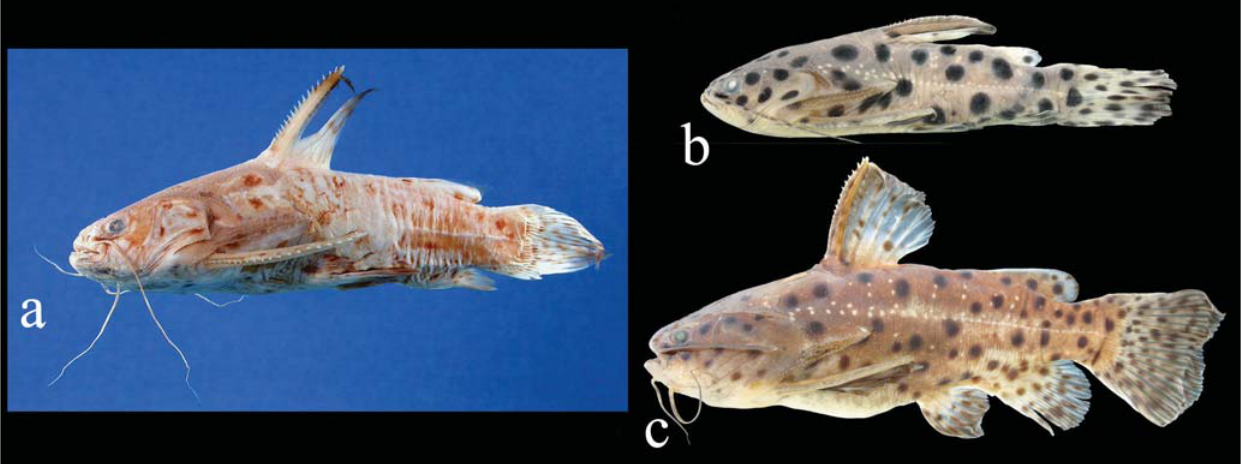
Fig. 11. Liosomadoras morrowi : ( a ) holotype, ANSP 68646, 76 mm SL, río Ucayali basin, Contamana, Peru (photo by K. Luckenbill); ( b ) INPA uncatalogued, 45.8 mm SL, rio Jutaí (3°51’39.5’’S 67°34’45.9’’W), Amazonas, Brazil; ( c ) UF 117251, 95.2 mm SL, río Nanay, Loreto,